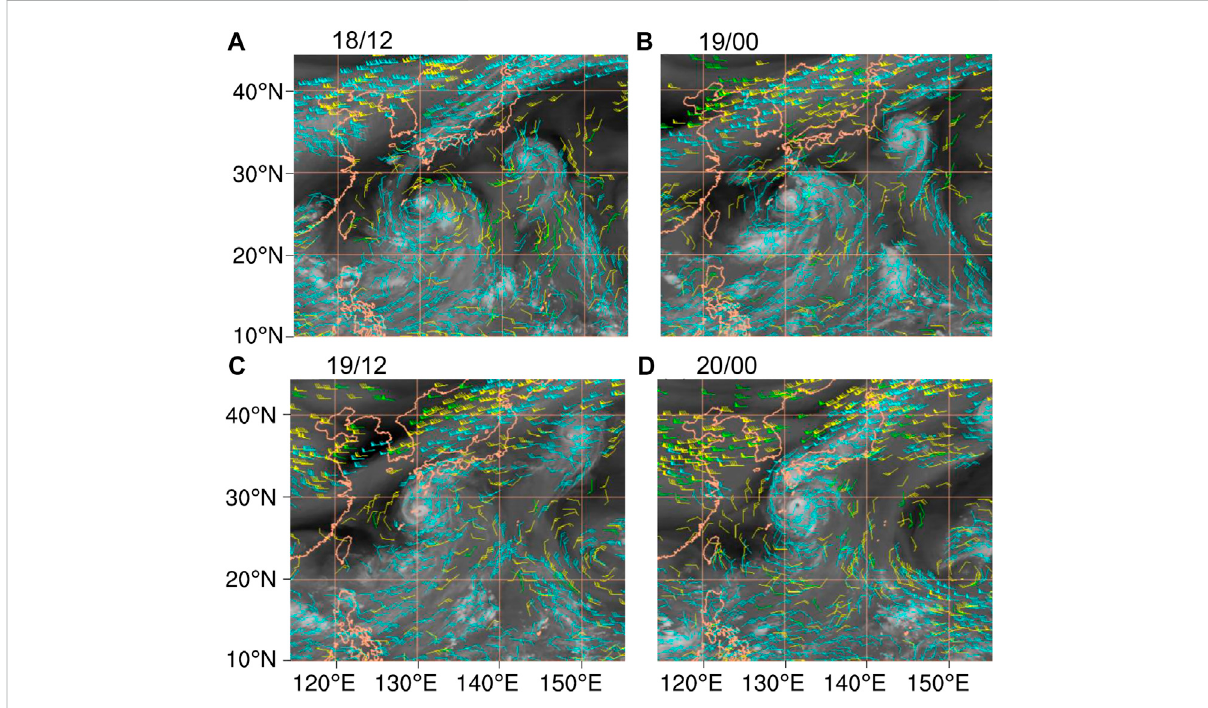
FIGURE 1 Mid-to upper-level satellite-derived wind (green: 351 – 500 hPa; yellow: 251 – 350 hPa; blue: 100 – 250 hPa) superimposed on the water vapor images for Typhoon Roke (2011) at (A) 1200 UTC 18 September, (B) 0000 UTC 19 September, (C) 1200 UTC 19 September and (D) 0000 UTC 20 September